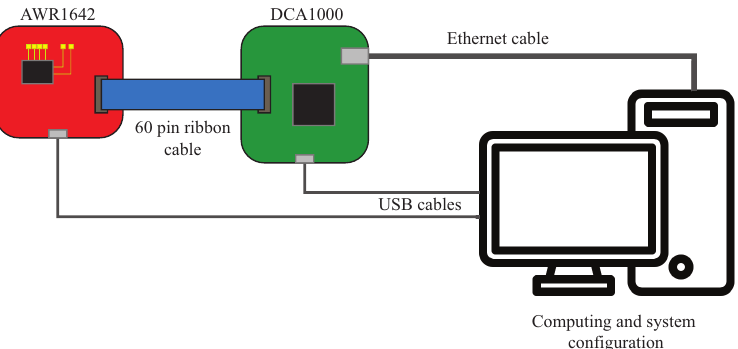
Figure 6. Connection scheme of the radar board, the FPGA board, and the